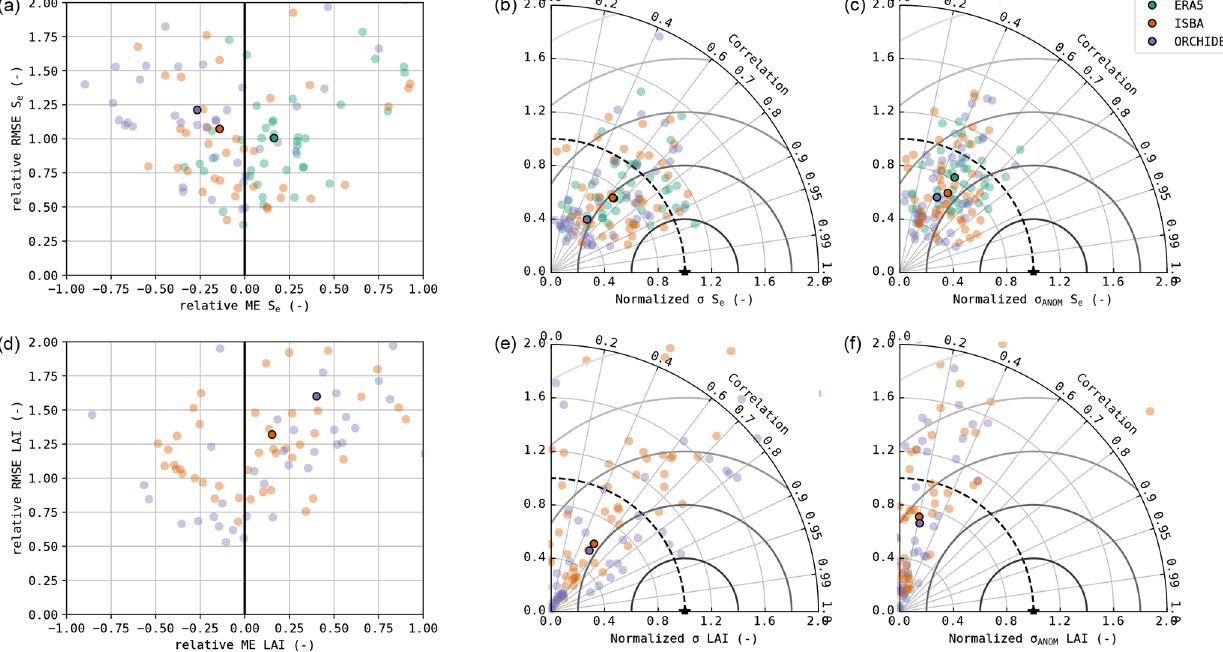
Figure 4. Accuracy plot (a, d) , Taylor diagram (b, e) and Taylor diagram of the seasonal anomalies (c, f) of S e (a–c) and LAI (d–f) . The median performance is shown with the opaque